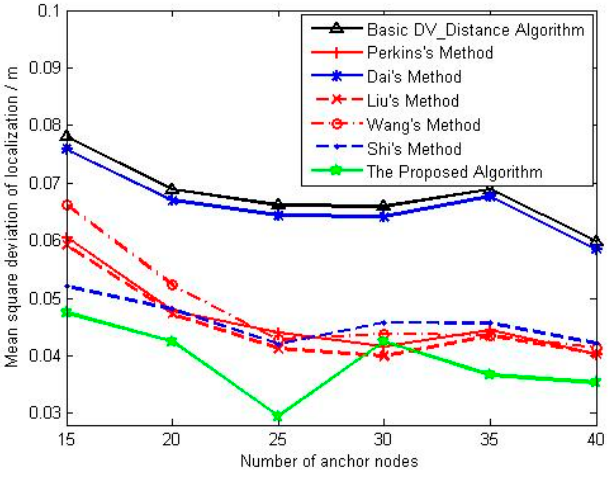
Figure 8. The change curve of mean square deviation with anchors density.